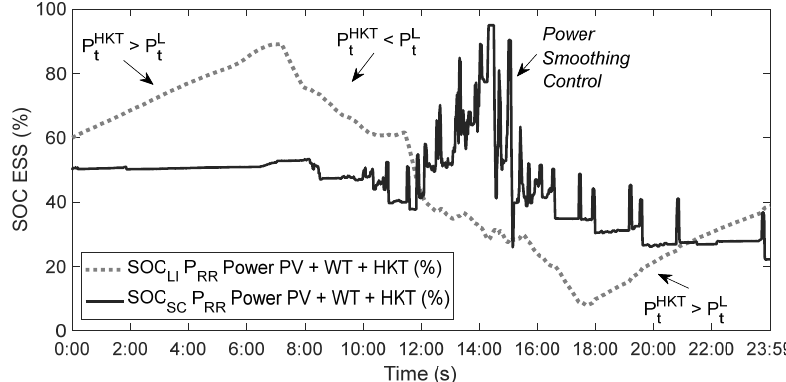
Figure 13. State of charge of the hybrid energy storage system for Configuration 3.